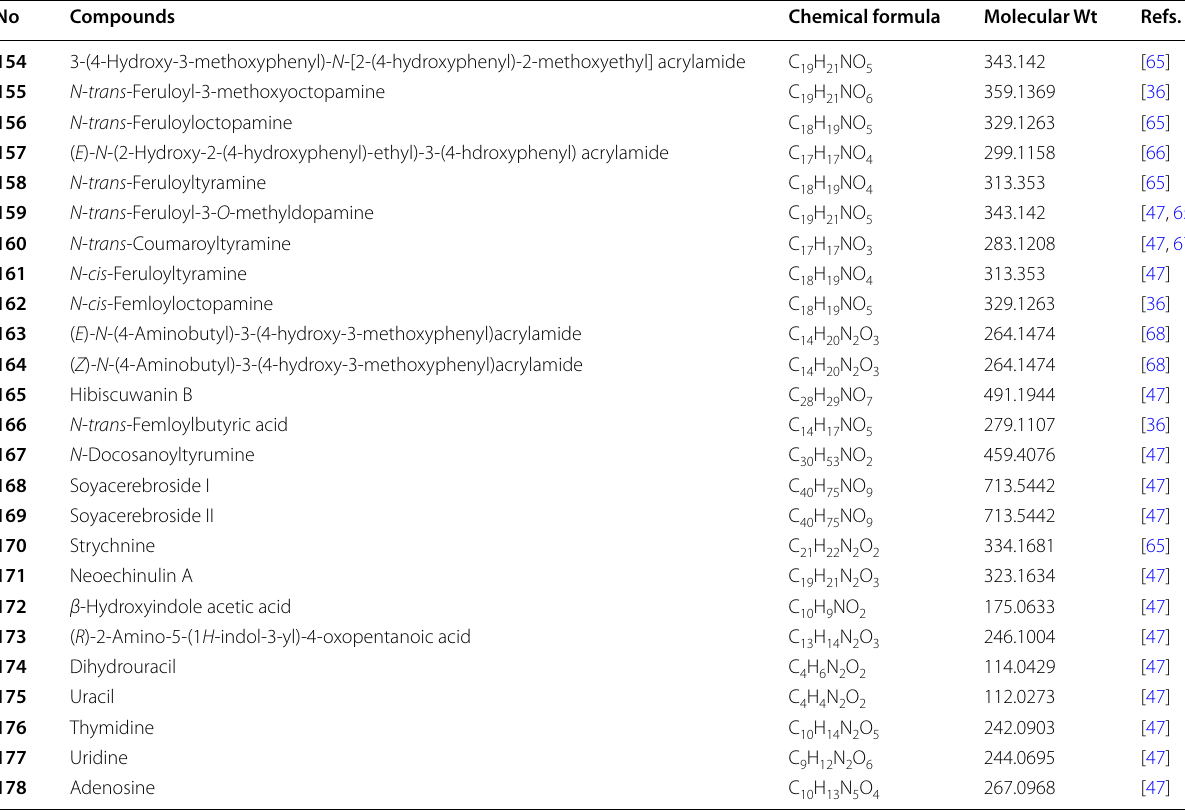
Table 8 Nitrogenous compounds isolated from S.